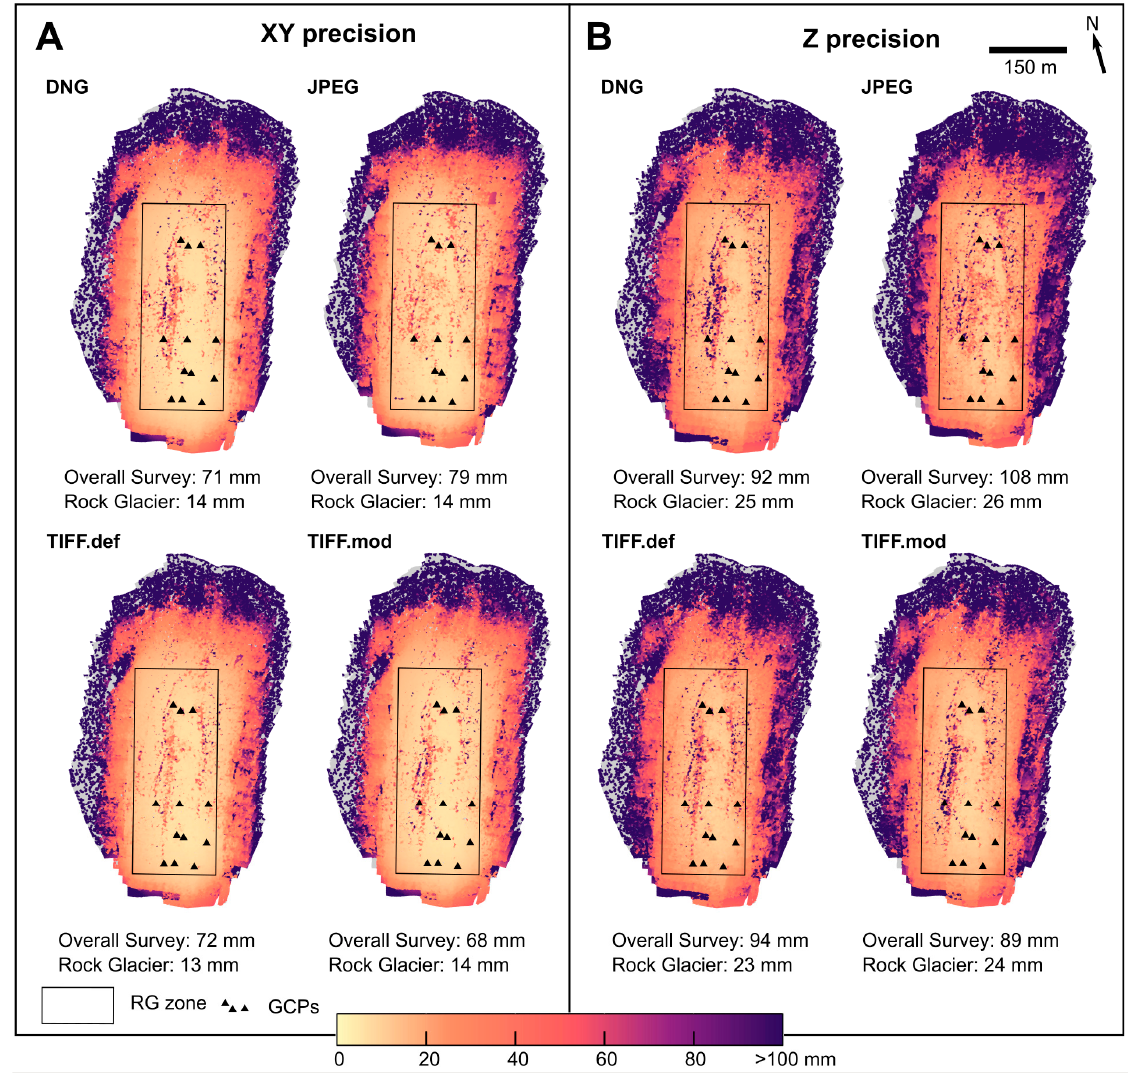
Figure 5. Three-dimensional variable precision distribution and values of the SfM surveys. Yellow colors represent high-precision points; purple colors represent lower-precision points. Overall and rock glacier mean precisions are displayed. ( A ) Dense cloud horizontal precision ( σ XY). ( B ) Dense cloud vertical precision ( σ Z).